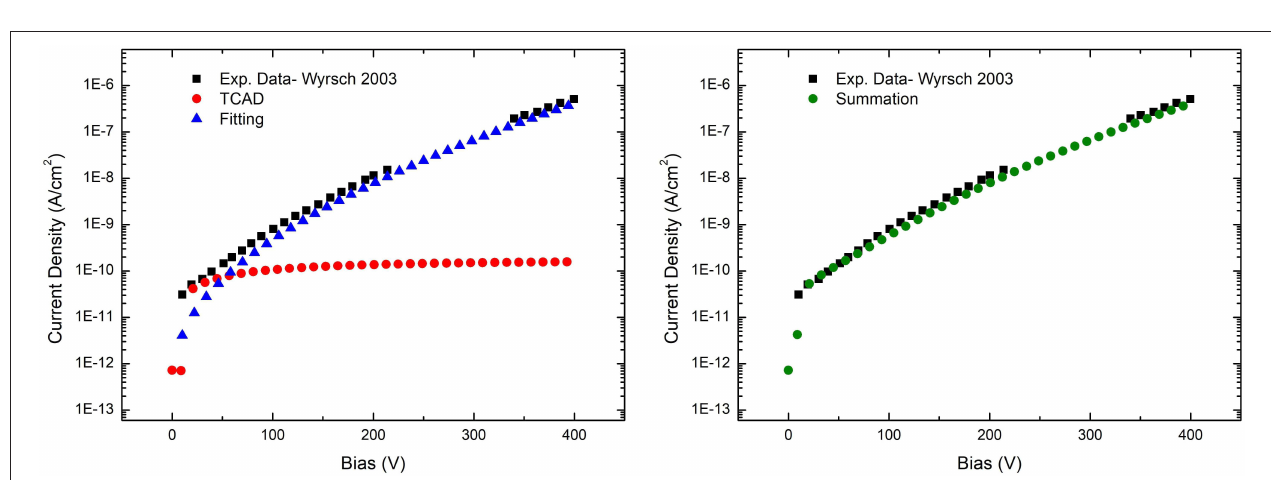
FIGURE 4 | Comparison of experimental (black square) and simulated (red circle) current density characteristics as a function of externally applied bias for the 12 µ m thick a-Si:H n-i-p device. A fitting function (Blue triangles) described by Equation (4) was employed to fit the field dependent components of the data. The summation of the simulated and fitted result (green circles) compared to the experimental result is presented on the right.